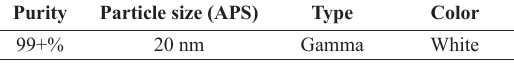
O nano-particles. 2 3